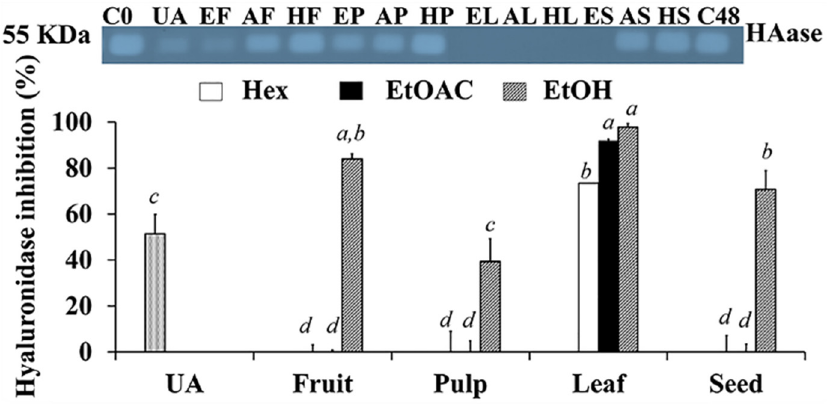
Figure 6. Inhibition against hyaluronidase of 1 mg/mL ursolic acid (UA) and various parts of C. carandas sequentially extracted using n -hexane (Hex), ethyl acetate (EtOAc), and 95% ethanol (EtOH), respectively. DMSO was used as a vehicle control at 0 h (C0) and 48h (C48). Various C. carandas extracts included n- hexane extracts from fruit (HF), leaf (HL), seed (HS) , and pulp (HP); ethyl acetate extracts from fruit (AF), leaf (AL), seed (AS) , and pulp (AP); ethanolic extracts from fruit (EF), leaf (EL), seed (ES) , and pulp (EP) . The letters a , b , c , and d denote significant difference among different C. carandas extracts ( p < 0.05) after being analyzed by one-way ANOVA followed by Tukey’s test.